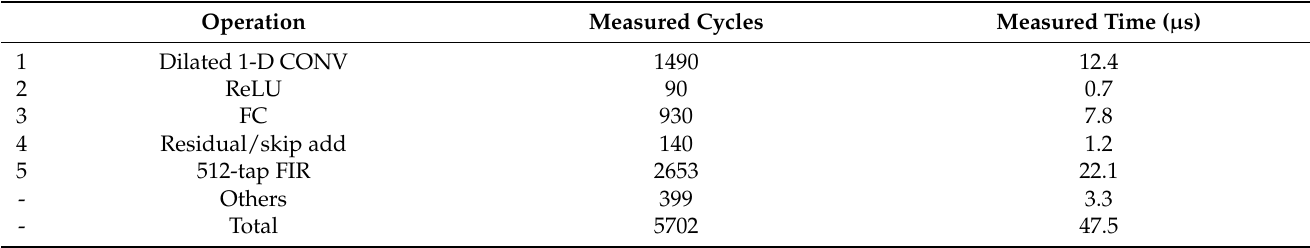
Table 1. Operation cycles of the proposed CNN model, to process three samples.